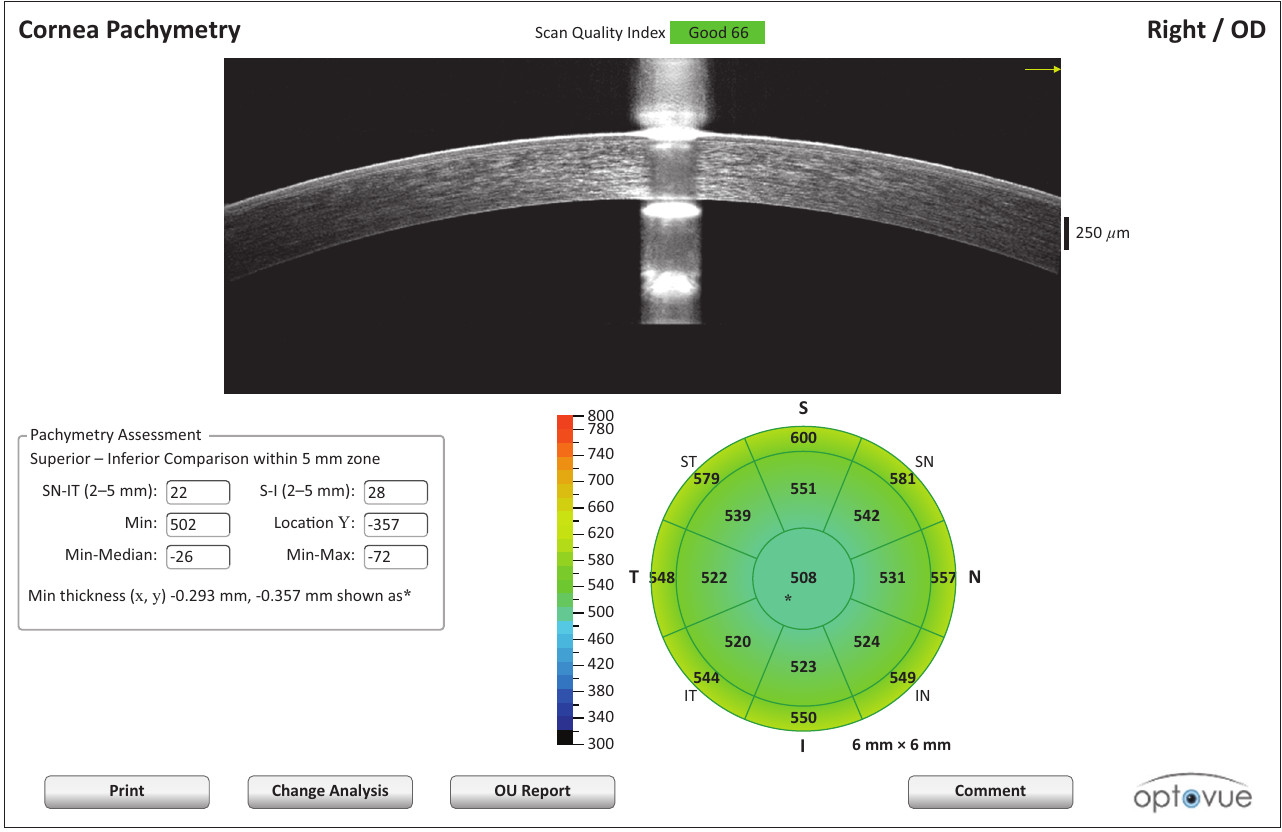
FIGURE 1: Corneal pachymetry map showing corneal tomogram (top), pachymetry assessment box (bottom left) and average corneal thickness in the centre and each zone of the paracentral and peripheral cornea (bottom